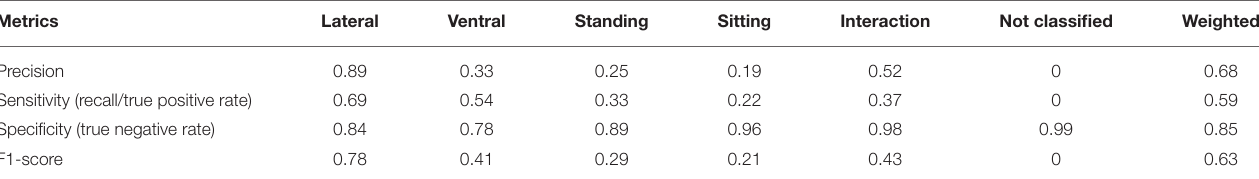
TABLE 6 | Multiclass classification performance for body posture/behaviors.